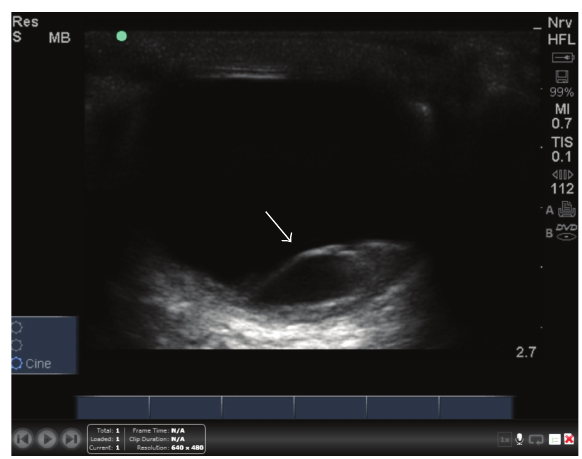
Figure 1: Left eye ultrasound shows retinal detachment.